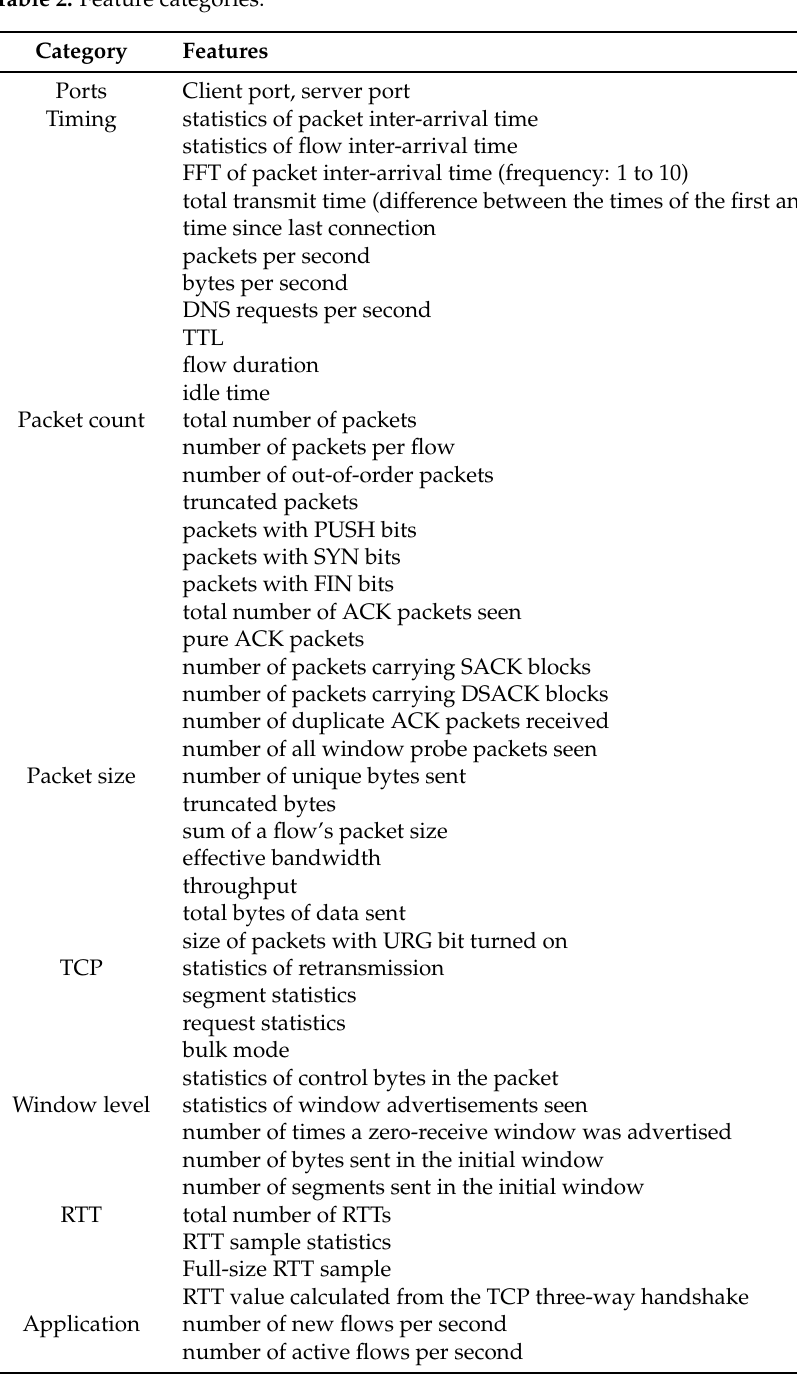
Table 2. Feature